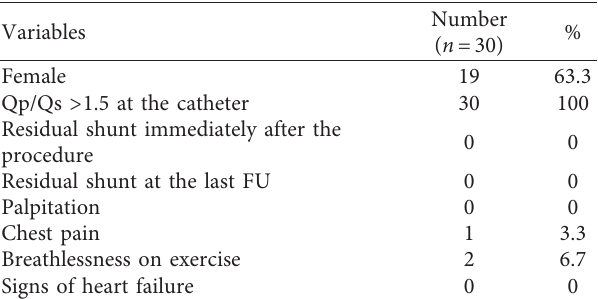
Table 2: Frequency of different symptoms and vital signs among the study group.